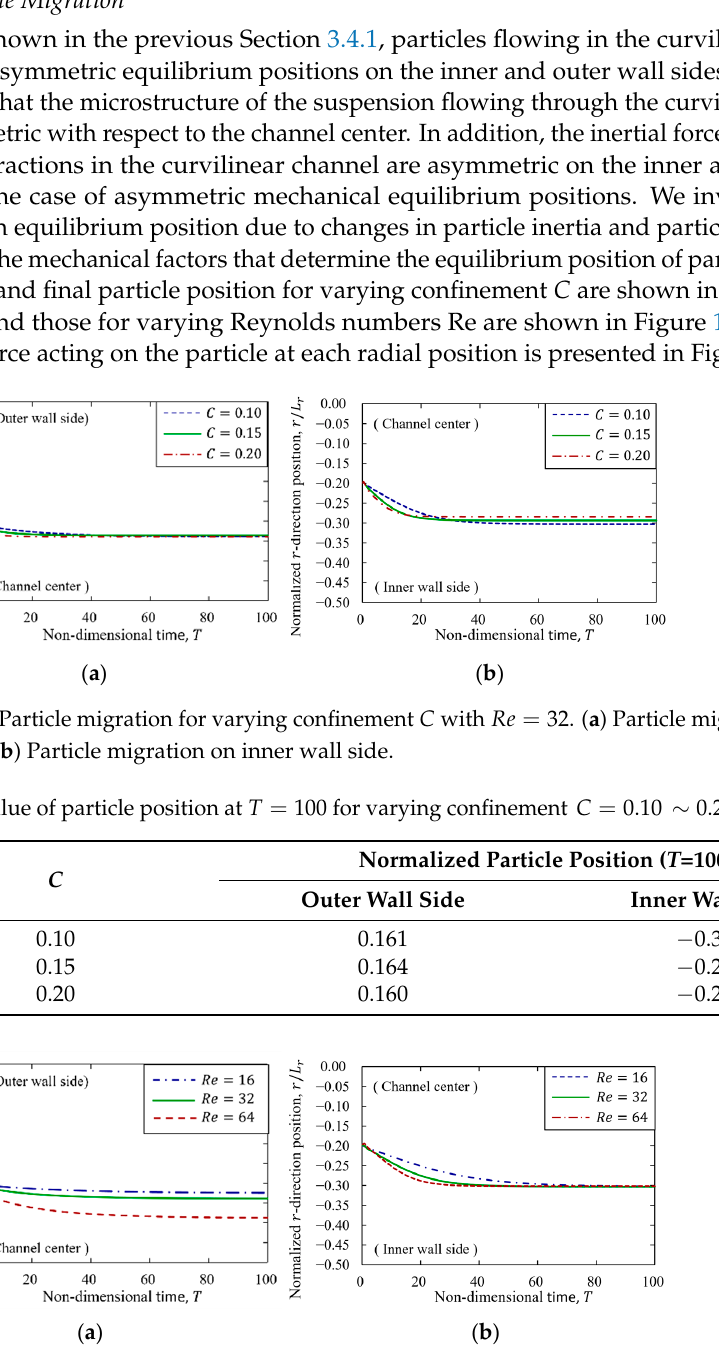
Figure 10. Lift coefficient acting on the particle for 𝑙 = 400 cells , 𝑅𝑒 = 32 and 𝐶 = 0.10 . In Figure 10, 𝐶 (cid:3013),(cid:2890)(cid:2919)(cid:2934)(cid:2915)(cid:2914) denotes the lift coefficient acting on the particle obtained by